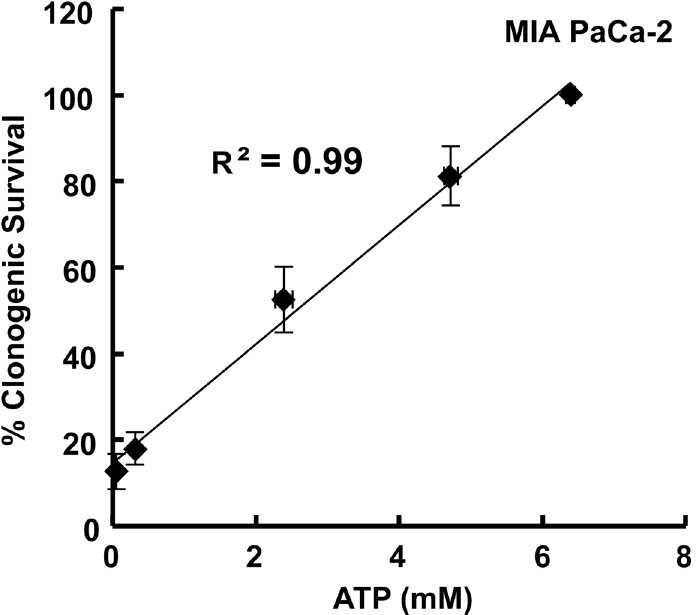
Fig 3. Clonogenic survival correlates directly with intracellular ATP concentration following exposure to 1,4-BQ. Clonogenic survival of MIA PaCa-2 cells following 4-h exposure to (0 – 1000 fmol cell -1 ) 1,4-BQ